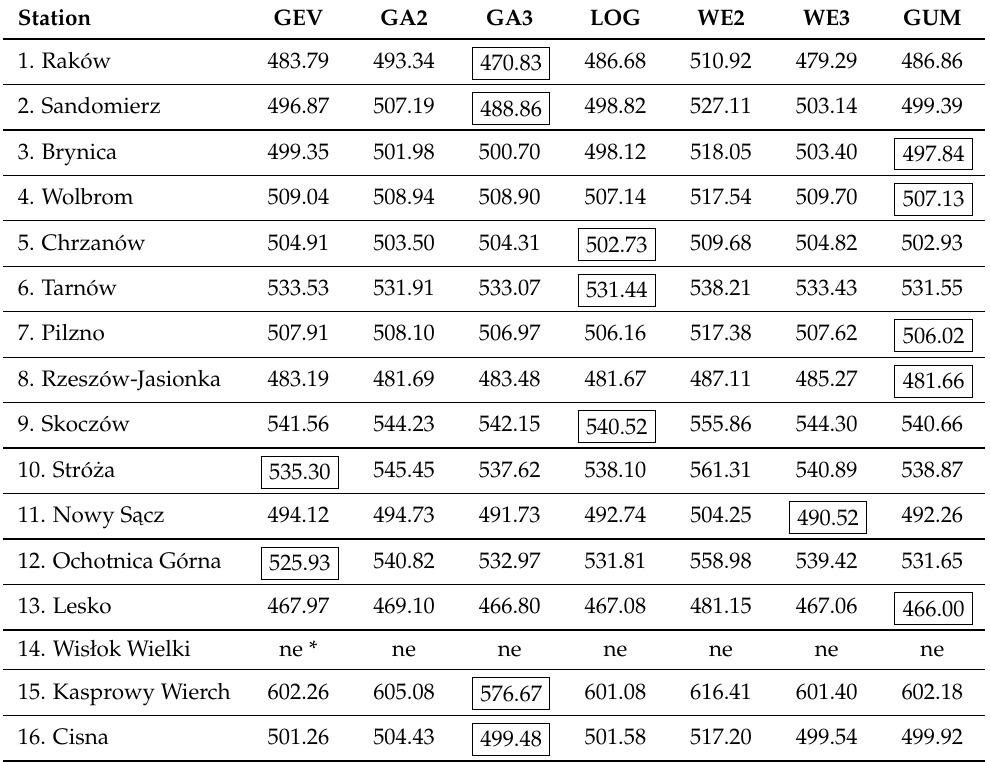
Table 5. The AIC values for the GEV, GA2, GA3, LOG, WE2, WE3, and GUM distributions. The lowest AIC values (in boxes) show the distribution functions that provide the best fit. Station